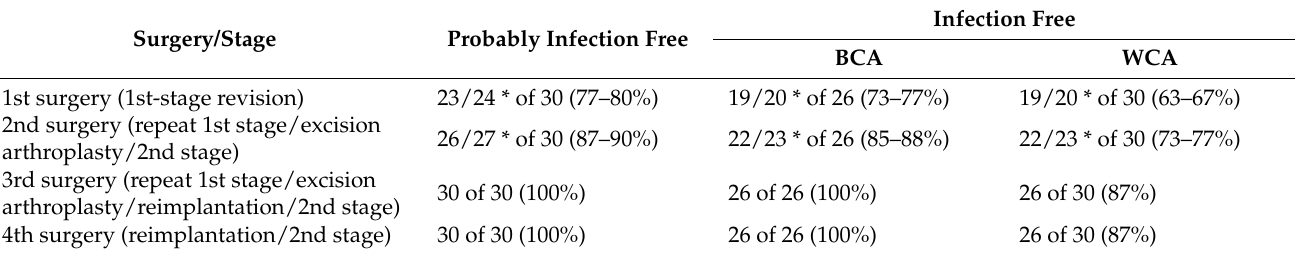
Table 5. Resolution of original infection.